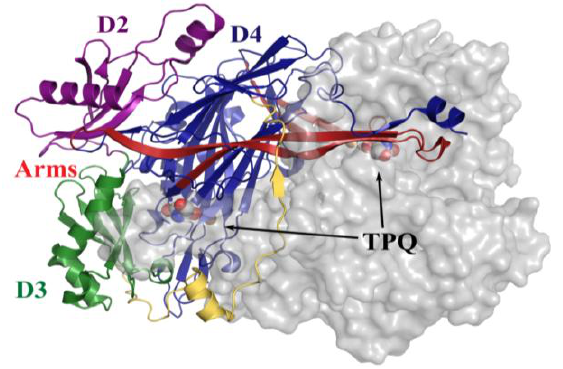
Figure 3. Overall fold of HPAO-1 viewed along the molecular dyad axis. One monomer is drawn in cartoon, and colored by domain (D2: purple; D3: green; D4: blue; connecting loop: yellow; β-hairpin arms: red). The second monomer is drawn as a semi-transparent molecular surface colored grey. TPQ from both monomers are drawn as space-filling spheres and colored by atom type (carbon,